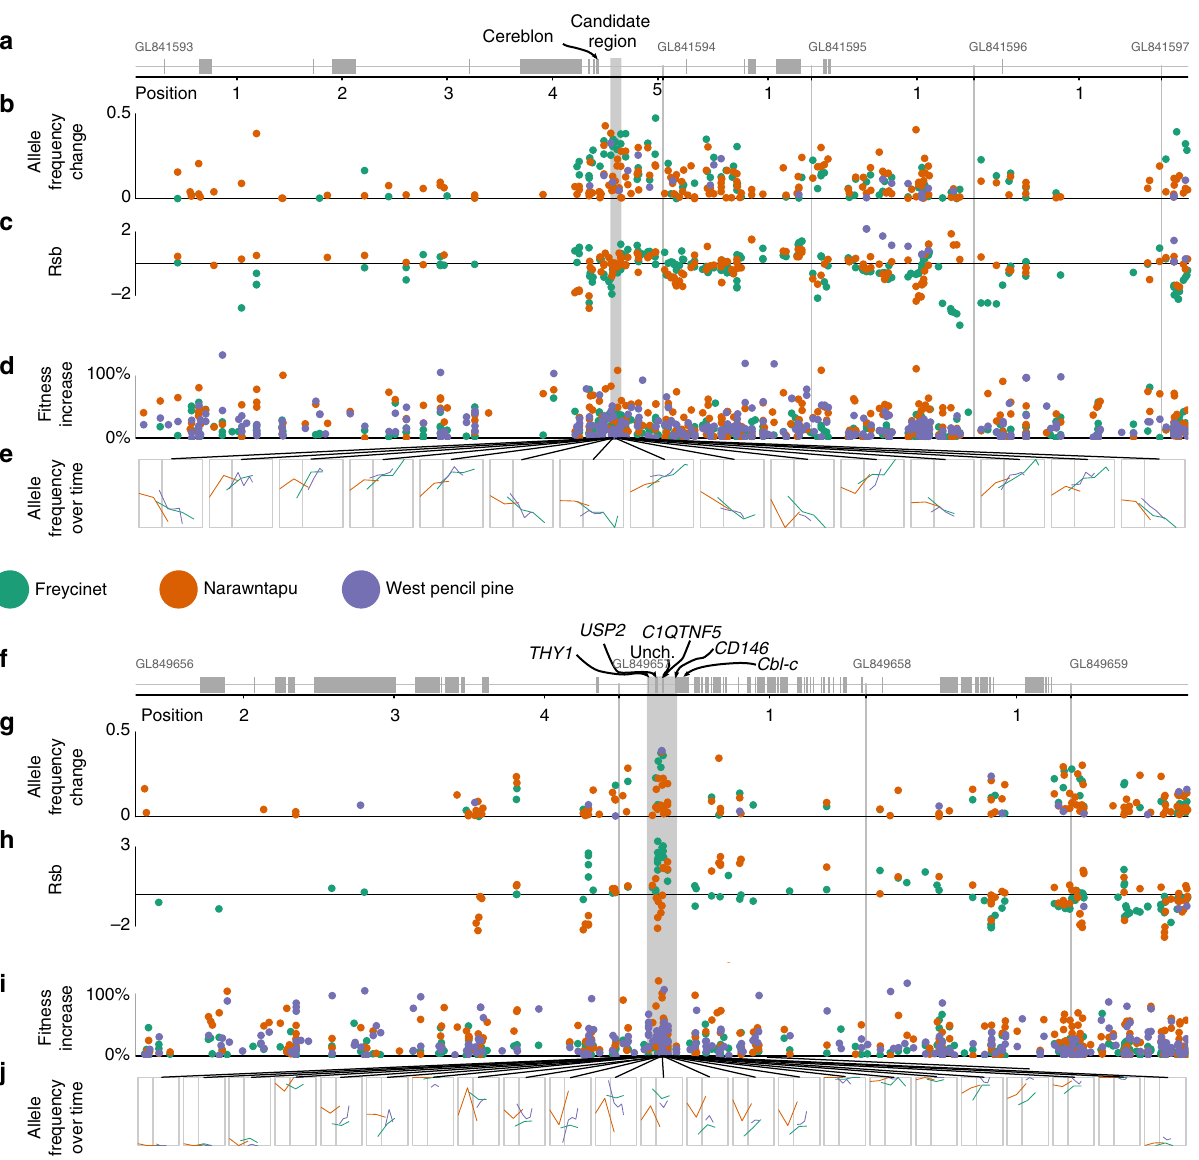
Figure 2 | Selection test statistics for each SNP in the candidate regions and approximately 4Mb on either side. Panels ( a – e ) are for chr. 2 and panels ( f – j ) are for chr. 3. The scaffolds, positions and genes (grey boxes) are shown in panels a and f , the positions are given in Mb from the start of each scaffold, which are marked with light grey vertical lines and a label (GL841593, and so on). Below those panels, values of three statistics are shown for each filter-passing SNP: ( b , g ) allele frequency change; ( c , h ) rsb; and ( d , i ) point estimates of the fitness advantage of the increasing allele. Panels e and j show the trajectory of allele frequency change over time; for clarity, we only show SNPs with relatively high genotyping rates and the x axis is time since detection of DFTD (first detection of DFTD is marked with a vertical line). SNPs are colour-coded by population, the candidate region is marked with a dark grey box and the names of candidate genes are labelled. Due to multiple steps of data filtering, each population has a different set of